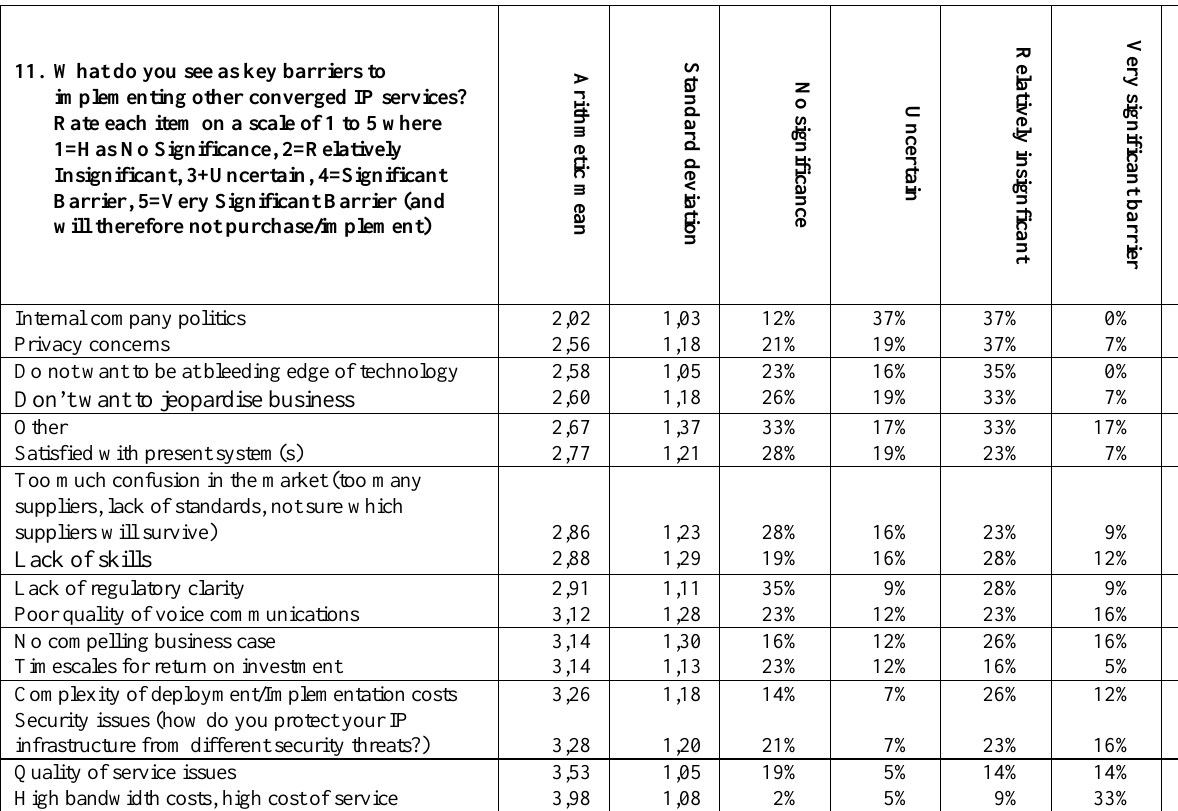
Figure 2: Factors likely to affect adoption of other converged IP